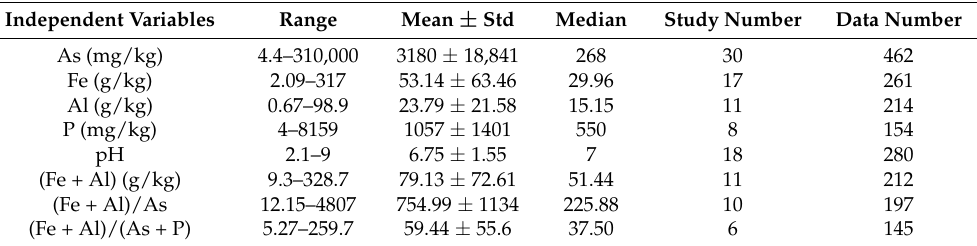
Table 2. Summarized Information for Model Descriptors.